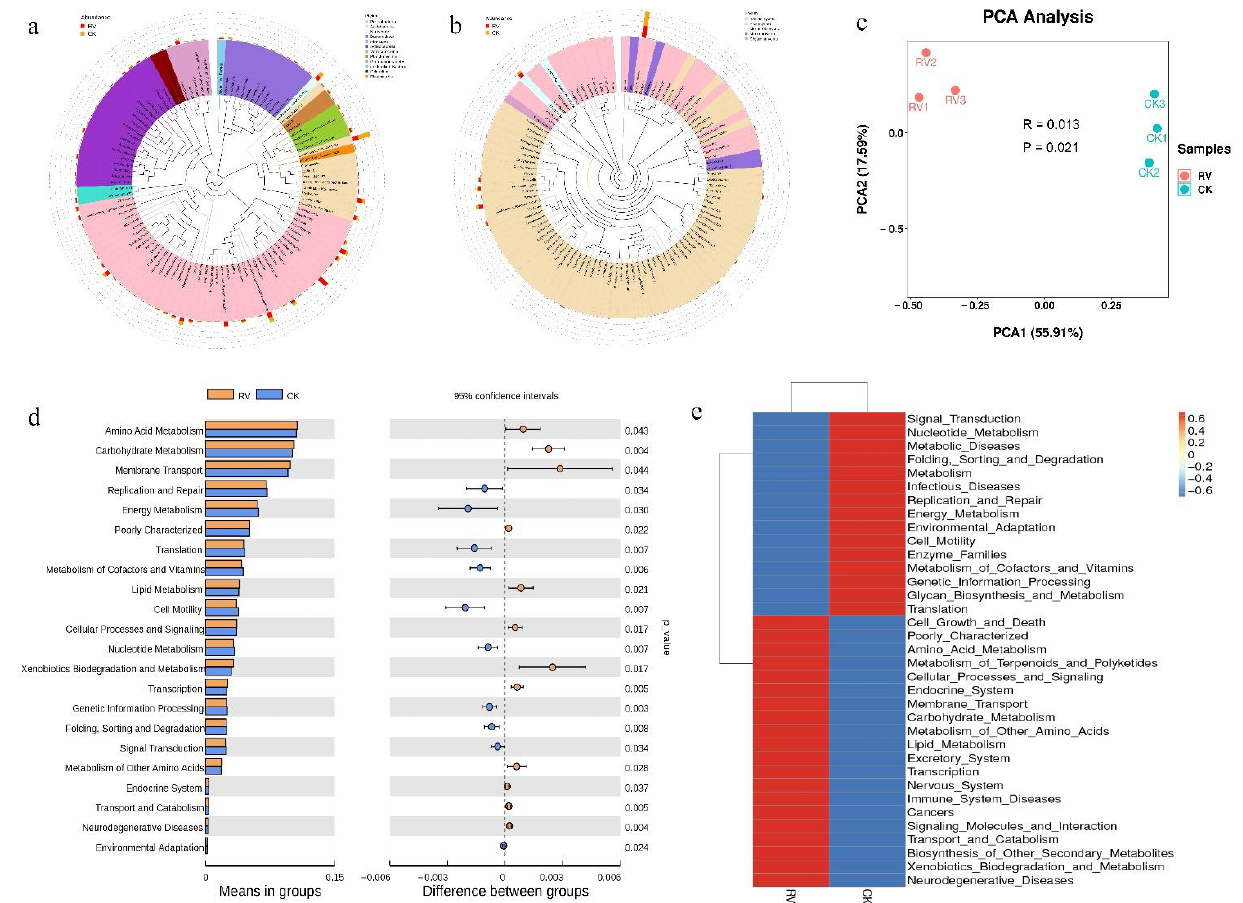
Figure 5. Effects of root-zone aeration on genus-level evolutionary trees and functional annotation of relative abundance: ( a ) Bacterial genus horizontal evolutionary tree. ( b ) Fungal genus horizontal evolutionary tree. ( c ) Functional prediction of PCA. ( d ) Bacterial functional annotation of relative abundance. ( e ) Bacterial functional annotation clustering heatmap (color scale: − 0.6 to 0.6 abundance